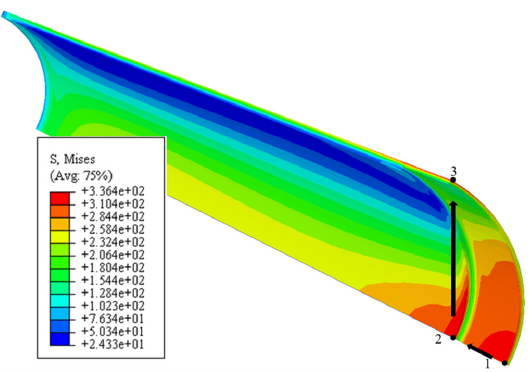
Figure 19. Schematic diagram of the maximum stress transfer path. (The direction of the arrow indicates the direction of movement of the point of maximum stress).